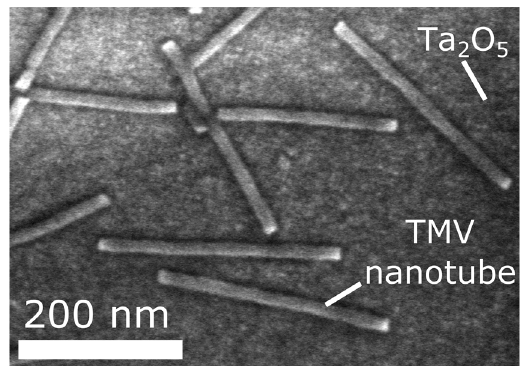
Figure 2. SEM image of the EIS sensor surface modified with TMV nanotubes with a typical length of about 300 nm and an outer diameter of 18 nm.